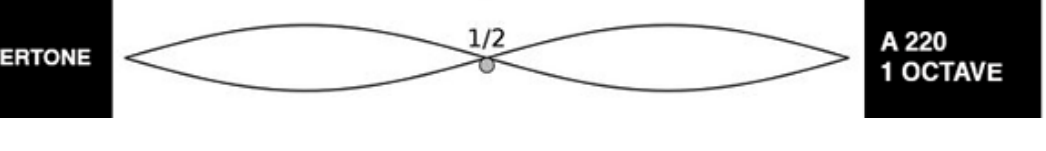
Figure 2. The First Overtone.